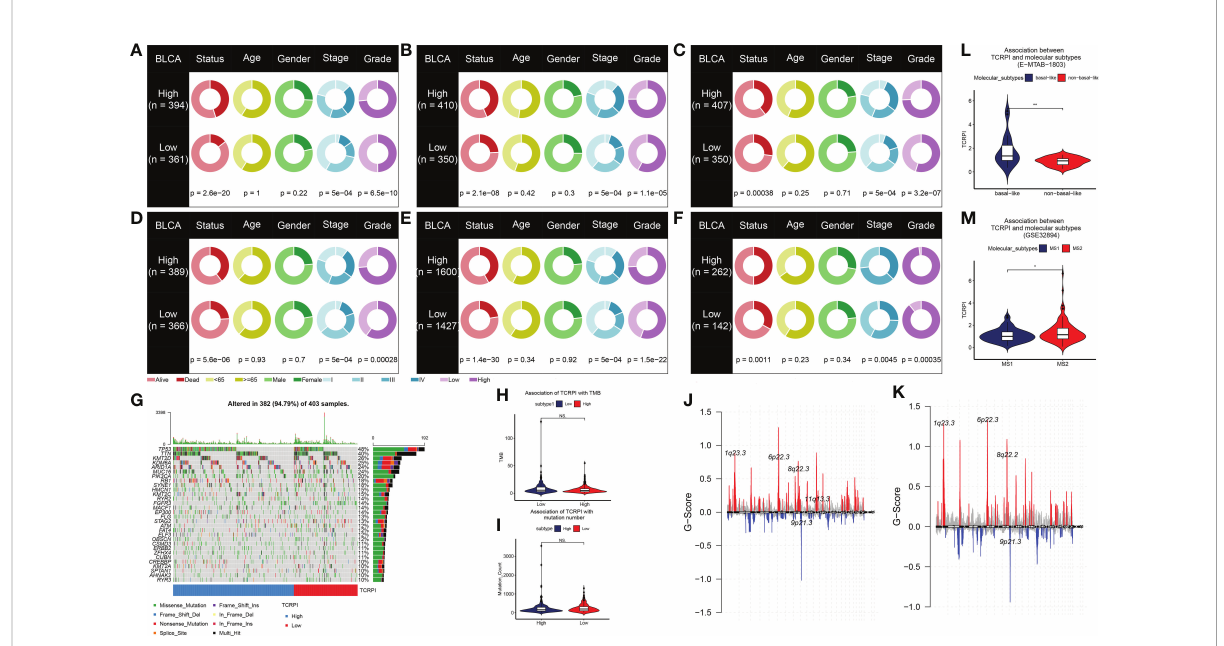
FIGURE 3 Association of TCRPI with clinical features and genomic correlations with TCRPI in the TCGA-BLCA data. The differences of clinical features (living status, age, gender, stage, and grade) across TCRPI-risk groups via meta-training cohort (A) , meta-testing cohort 1 (B) , meta-testing cohort 2 (C) , meta-testing cohort 3 (D) , meta-entire cohort (E) , and the TCGA-BLCA cohort (F) . (G) The oncoplot of the top 30 mutated genes that were associated with TCRPI. (H) Association of TCRPI with TMB. (I) Association of TCPRI with mutation number. (J) G-score distribution among the TCRPI-high risk group. (K) G-score distribution among the TCRPI-low risk group. (L) Association of TCPRI with molecular subtypes (basal-like, non-basal-like) using cohort E-MTAB-1803. (M) Association of TCPRI with molecular subtypes (MS1, MS2) using cohort GSE32894. NS, no signi fi cance, *P <0.05, **P